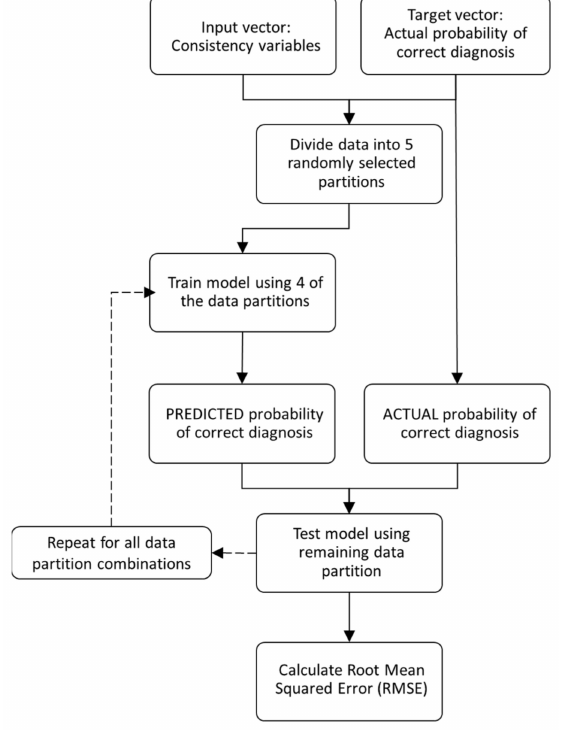
Figure 4. Flowchart of the machine learning